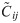
Sector identification for the G protein family.A shows the IC-based sub-matrix of the C˜ij matrix for the G protein family and and B-C shows the structural interpretations on a representative member of the family (H-Ras, PDB 5P21 [48]). IC4 represents a nearly independent group of coevolving positions (sector 2, red), while ICs 1, 2, and 3 show strong inter-IC correlations that suggest classification as a single hierarchically-organized sector (sector 1, different shades of blue). B, Structurally, sector 1 comprises the nucleotide binding pocket (IC1) and the connection to so-called switch domains 1 and 2 which interact with downstream target proteins (ICs 2 and 3). Together, these regions correspond to the known allosteric mechanism in the G protein family. Sector 2 corresponds to a distinct, largely contiguous group of amino acids with yet unclear functional role. C, The three ICs comprising sector 1 mapped on the atomic structures of the active GTPγS bound state (PDB 5P21 [48], left panels) and inactive GDP-bound state (PDB 4Q21 [49], right panels) of H-ras. The data show that ICs 1 and 2 show substantial state-dependent conformational change. These same ICs also show distinct patterns of variation along different G protein sub-types (Fig 7A), suggesting that variations in these ICs tunes allosteric or substrate binding properties.